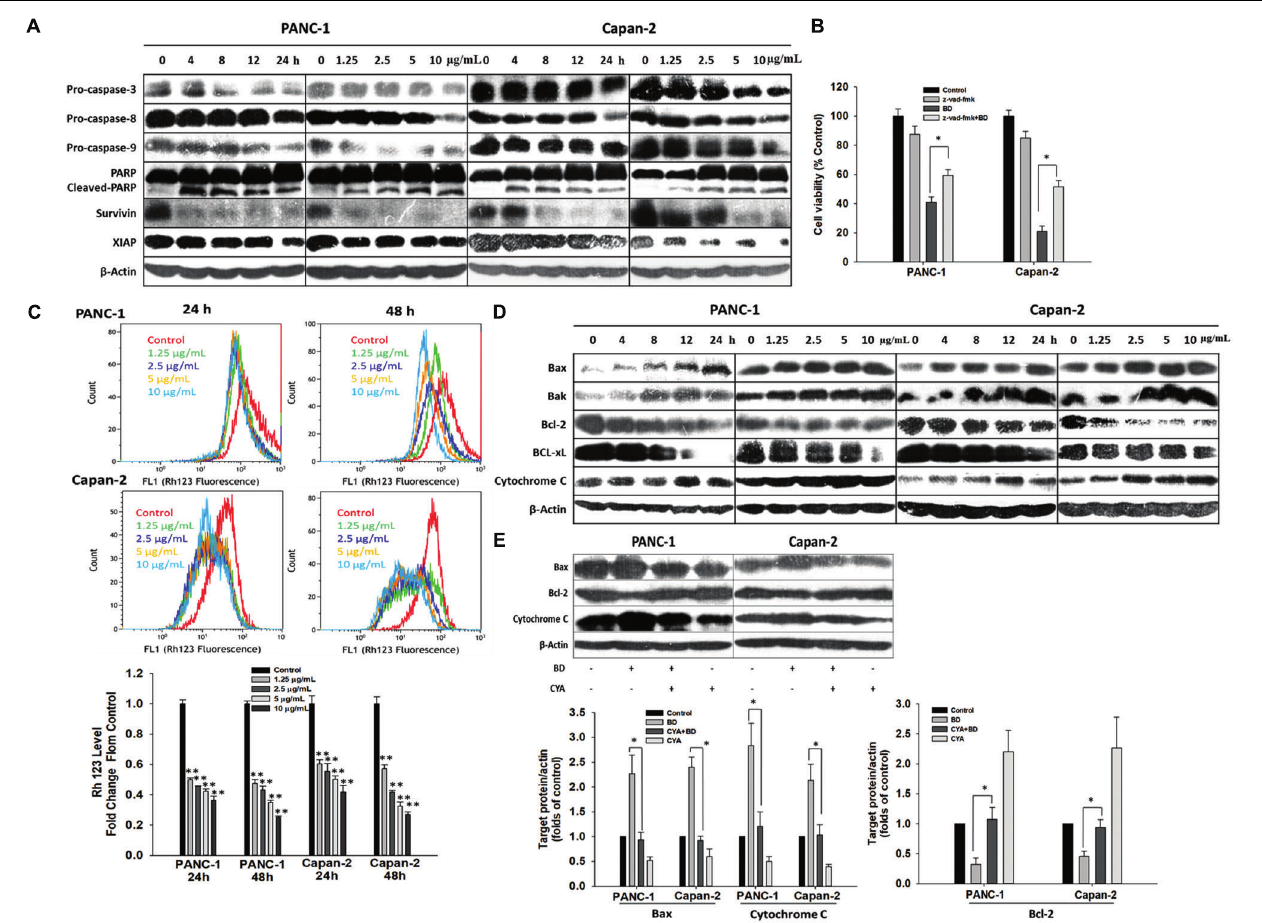
FIGURE 3 | BD triggers caspases/mitochondria-dependent apoptosis. (A) Cells were treated with BD either at concentrations of 1.25, 2.5, 5, and 10 µ g/mL for 12 h or at 5 µ g/mL for various durations of 4, 8, 12, and 24 h. The cell lysates harvested were analyzed for expression of PARP-1, pro-caspase-3, pro-caspase-8, pro-caspase-9, Survivin and XIAP by Western blotting. β -Actin served as the protein loading control. (B) Z-VAD-FMK (caspase inhibitor, 50 µ M) was added simultaneously with BD to PANC-1 and Capan-2 cells. Cells were harvested for cell viability analysis by MTT assay. (C) Cells were treated with BD at the indicated concentrations for 24 and 48 h and were stained by Rhodamine 123 to determine the change of (cid:49)(cid:57) m by flow cytometry. (D) Protein expression involved in the mitochondrial function were measured by Western blotting in both PANC-1 and Capan-2 cells treated with various concentrations of BD for 12 h or at 5 µ g/mL for different treatment durations. β -Actin served as the protein loading control. (E) Western blotting analysis of Bax, Bcl-2, and cytochrome c levels after cells were incubated with cyclosporine A (10 µ M) or BD (5 µ g/mL) alone or in combination for 24 h. β -Actin served as the protein loading control. Each bar represents means ± SD of three independent experiments. ∗ P < 0.05 and ∗∗ P < 0.01 vs the control group.